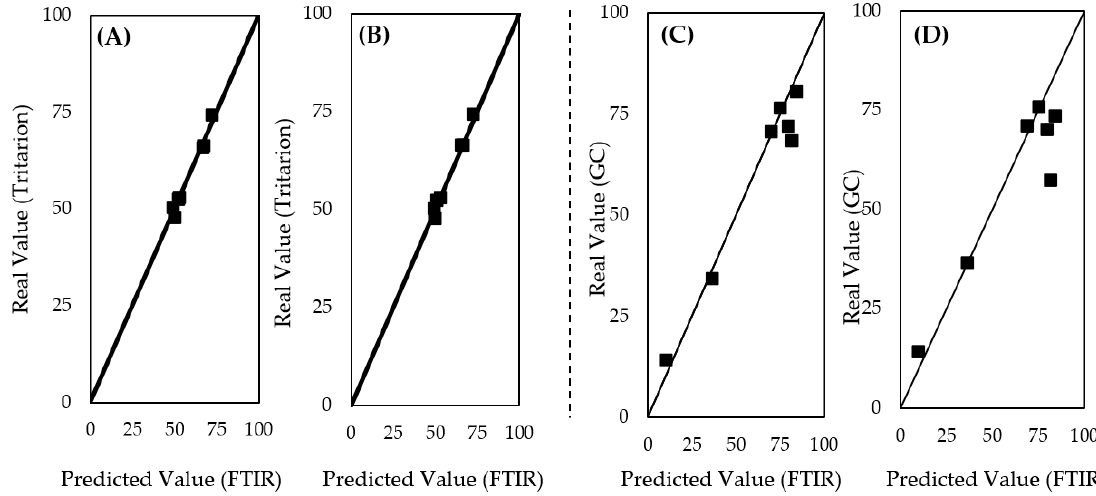
Figure 5. FFA ( A , B ) and FAME ( C , D ) contents in acid olive pomace oil predicted by FTIR spectroscopy against real values (titration method and GC method). ( A ) Abs (FTIR) = 0.0171 × % FFA + 0.3238; ( B ) Abs (FTIR) = 0.0174 × % FFA + 0.3154; ( C ) Abs (FTIR) = 0.0137 × % FAME + 0.2002; and ( D ) Abs (FTIR) = 0.0162 × % FAME + 0.2159. Line of unit slope represents zero error between experimental and real